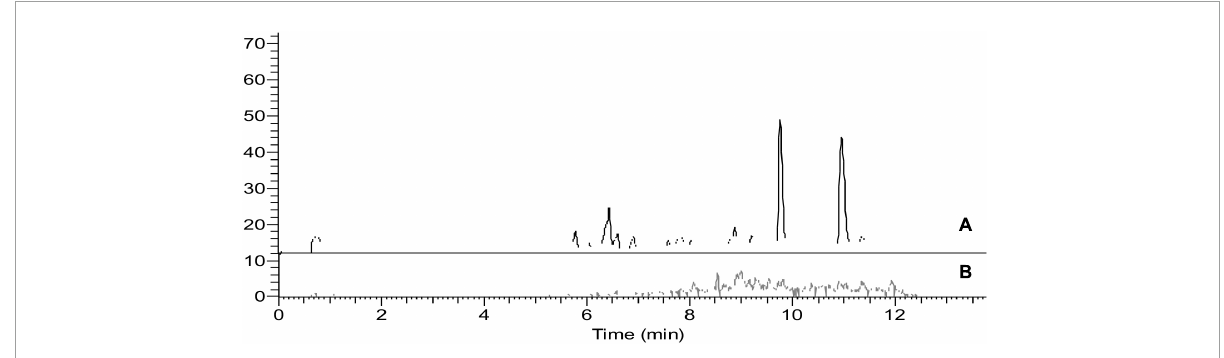
FIGURE3 Representative chromatograms of blank orange final extract after 20 × dilution. (A) Full scan mass spectrum (B) Single Ion monitoring of the parent ion 422.2 m/z of fenpyroximate.